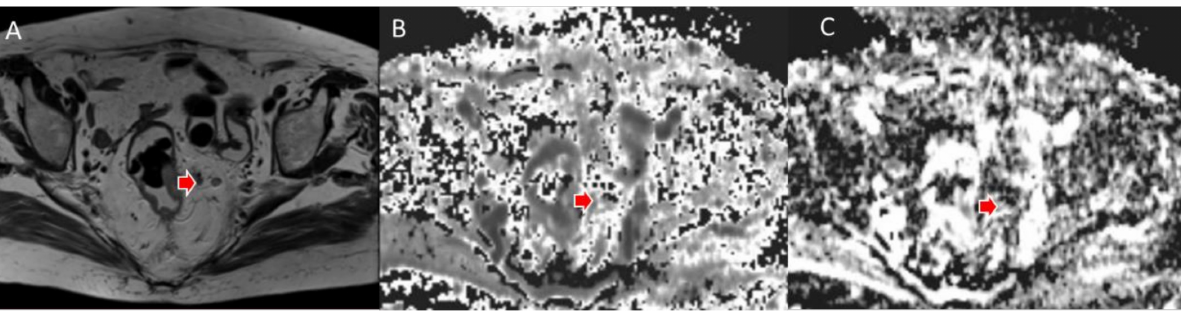
Figure 4. Woman 65 y.o. with rectal cancer (same patient as in Figure 2). Tumor deposit (arrow) assessed in T2W sequence ( A ), in MK map ( B ) and MD map ( C ).